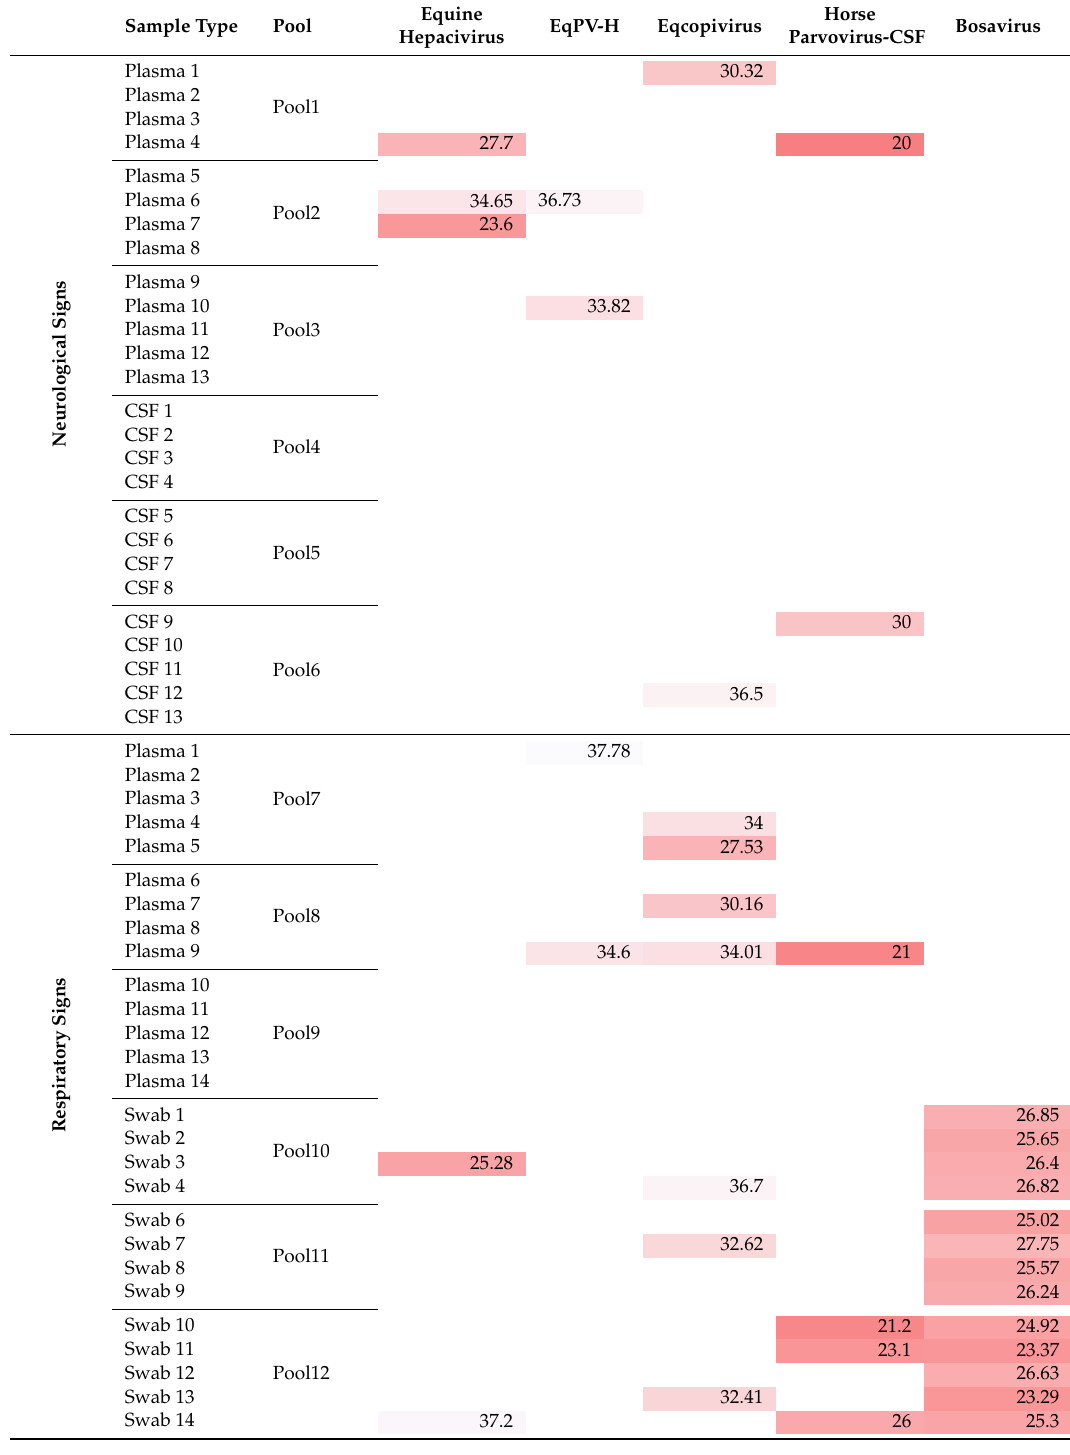
Table 2. Real-time PCR results and Ct values. Within each of the 2 clinical groups di ff erent samples from the same animals are labeled with the same number. Lowest to highest Ct labeled red to